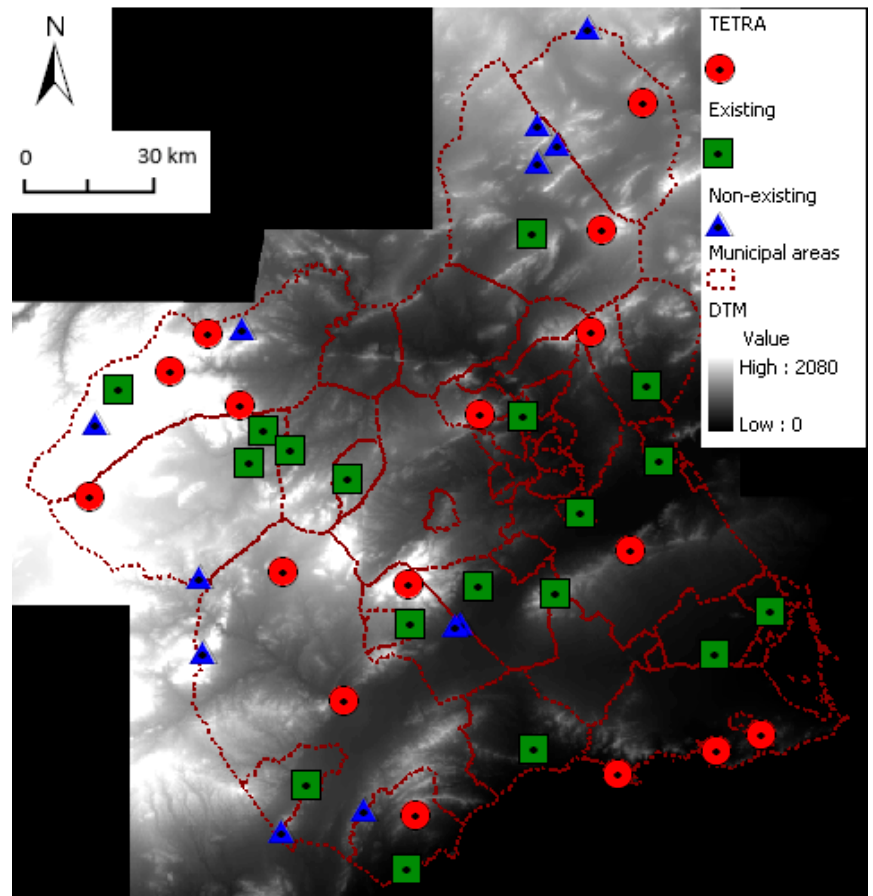
Figure 3. Digital terrain model (raster), sites (vector points) and municipal areas (vector polygons).